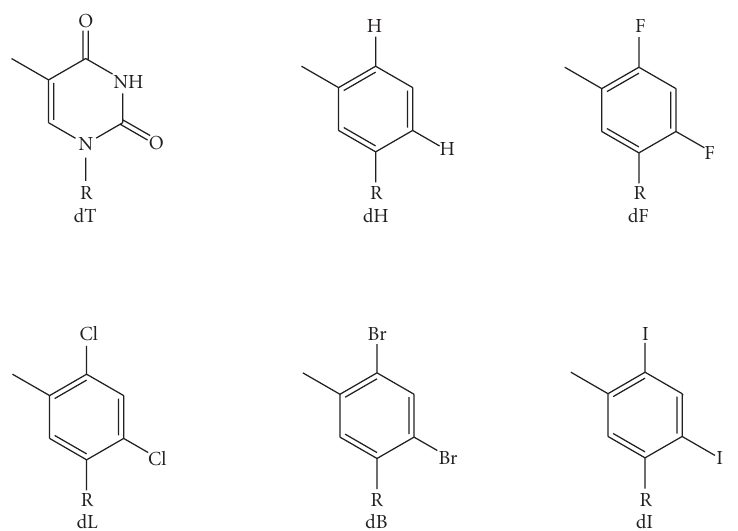
Figure 9: Small molecule thymidine (dT) analogs: 3-toluene-1- β - D -deoxyriboside (dH); 2,4-difluoro-5-toluene-1- β - D -deoxyriboside (dF); 2,4-dichloro-5-toluene-1- β - D -deoxyriboside (dL); 2,4-dibromo-5-toluene-1- β - D -deoxyriboside (dB); 2,4-diiodo-5-toluene-1- β - D - deoxyriboside (dI) [111]. The deoxyribose groups are indicated by